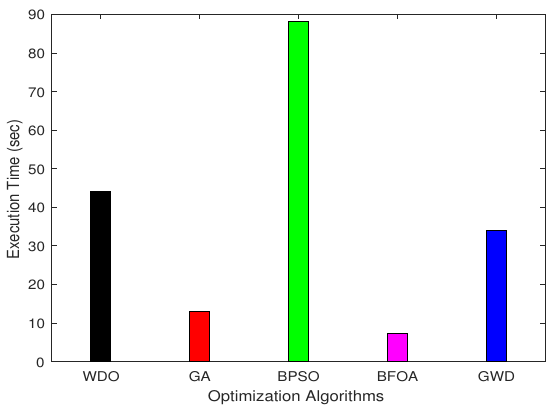
Figure 19. Execution time of GA, BPSO, WDO, BFOA and GWD.